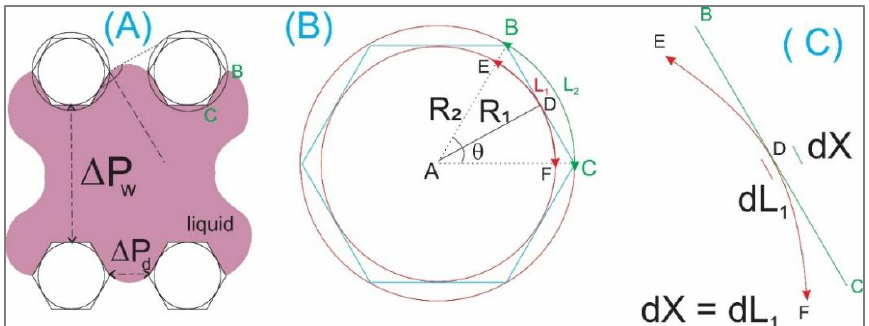
Figure 4. ( A , B ) denote parameters for analysis of the similarity of a hexagon and its inscribed and circumscribed circles. ( C ) An enlarged image of the curves at the water contact line.